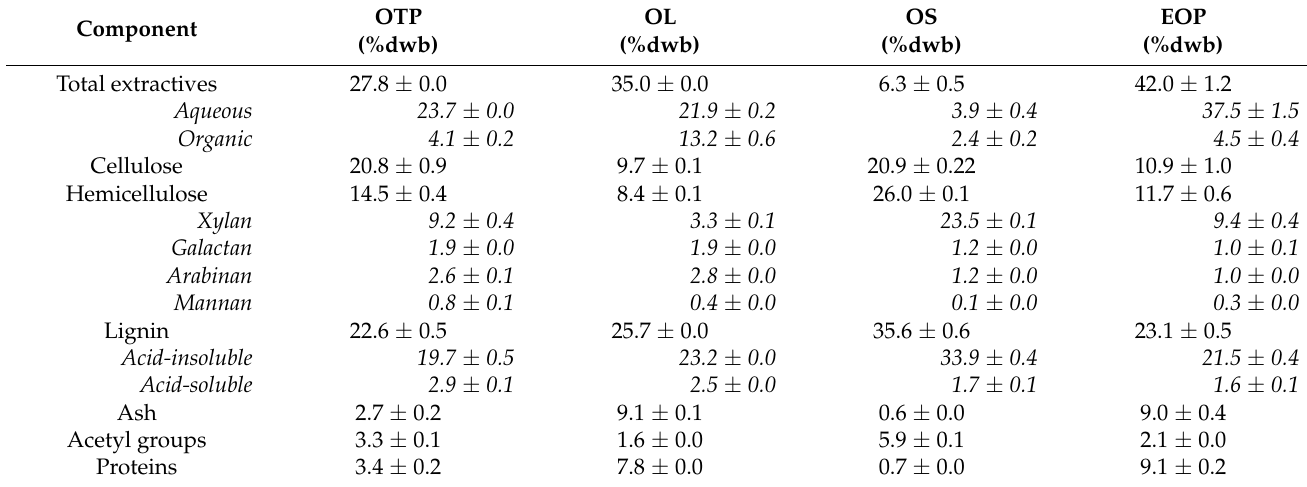
Table 1. Biomass composition of different olive by-products in dry weight basis (dwb) of the raw biomass.